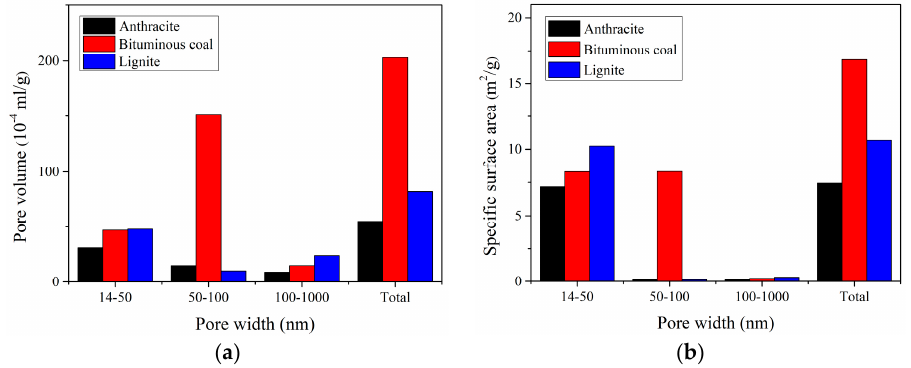
Figure 7. PSD and SSA of the coal samples for MIP method: ( a ) PSD of the coal samples; ( b ) SSA of the samples.